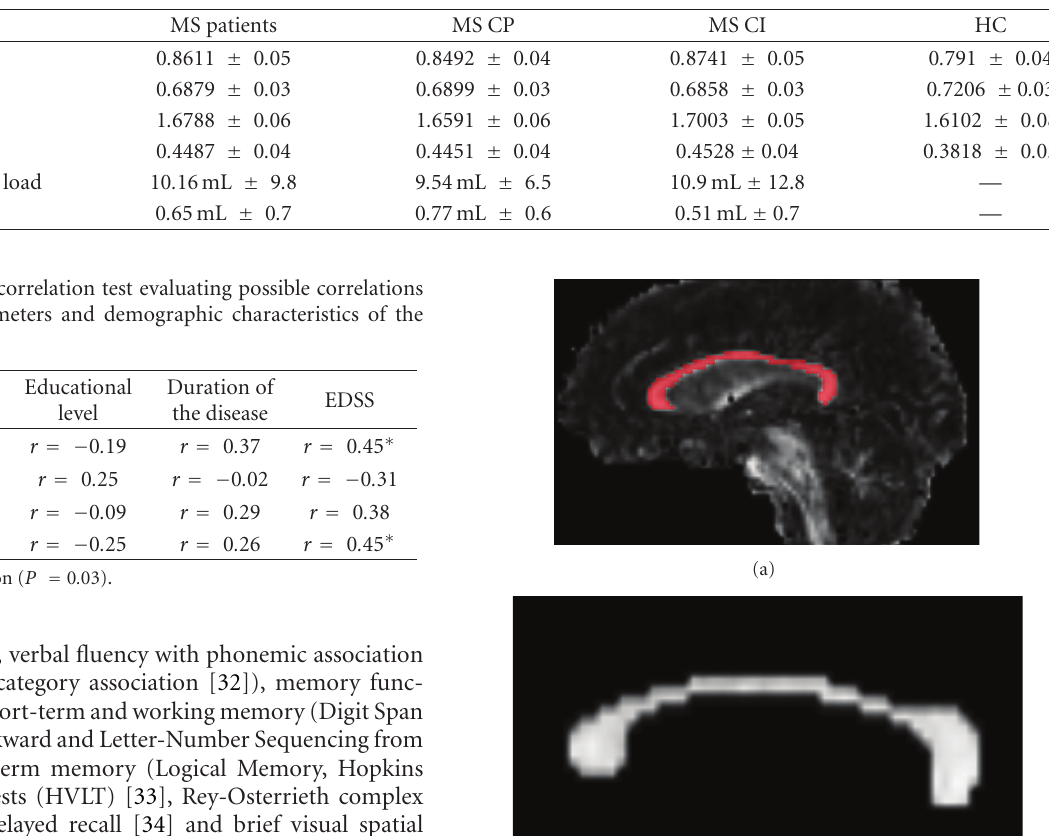
Table 1: Results of DTI scalar maps (FA and MD) and vectorial di ff usivity (AD and RD) in MS patients and healthy controls.